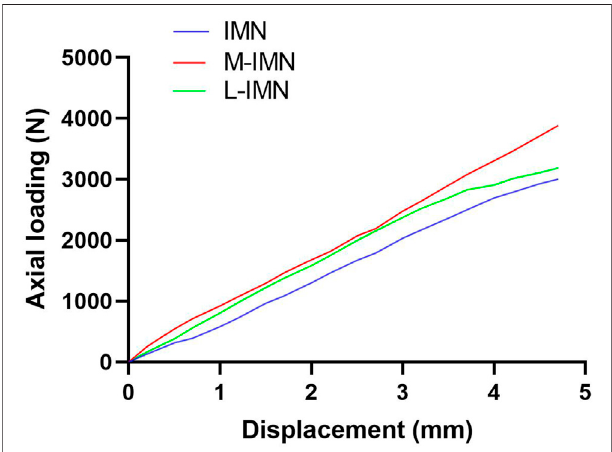
FIGURE 4 | Axial compression loading curves in different